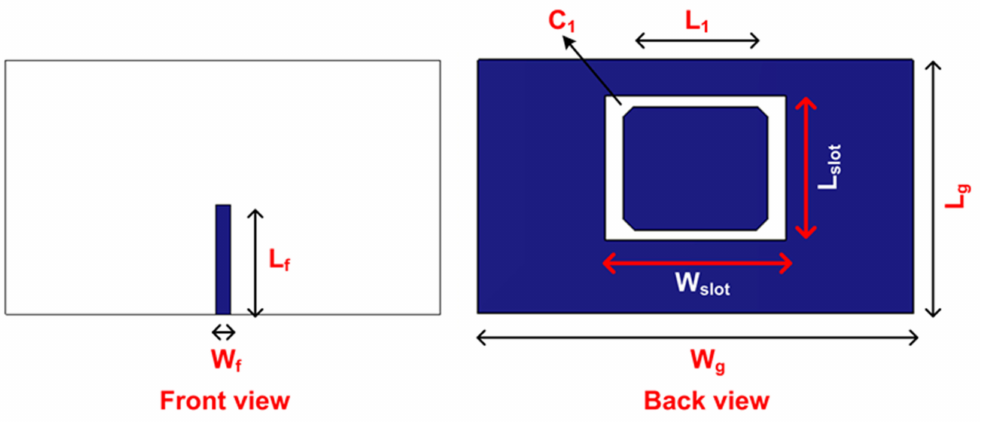
Figure 1. The geometry of the proposed rectangular slotted antenna with a parasitic